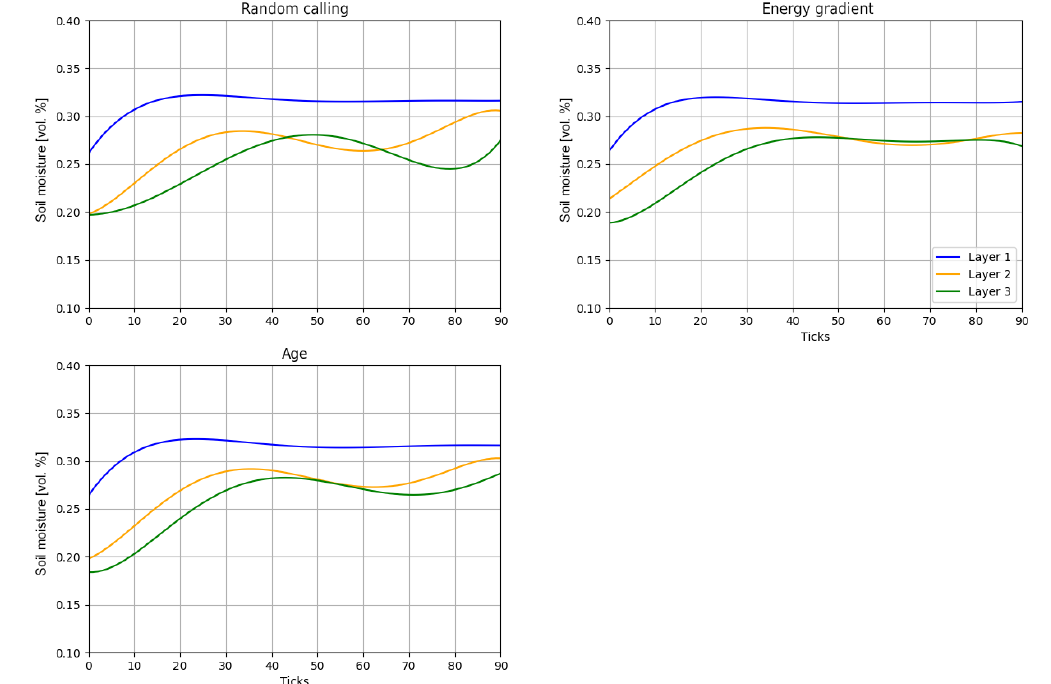
Figure 5. Analysis of different scheduling methods for the soil column with two different soils.